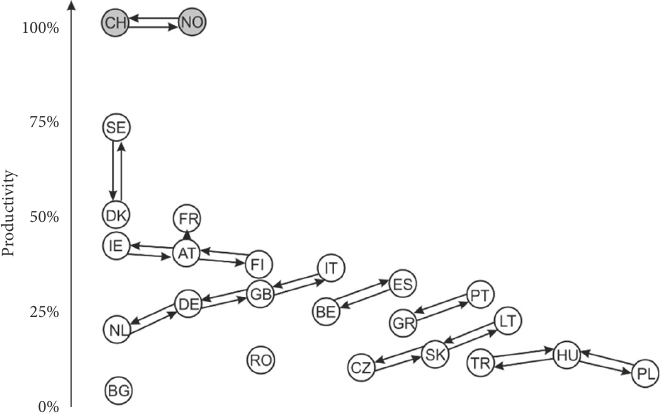
Fig. 11. Groups of technological